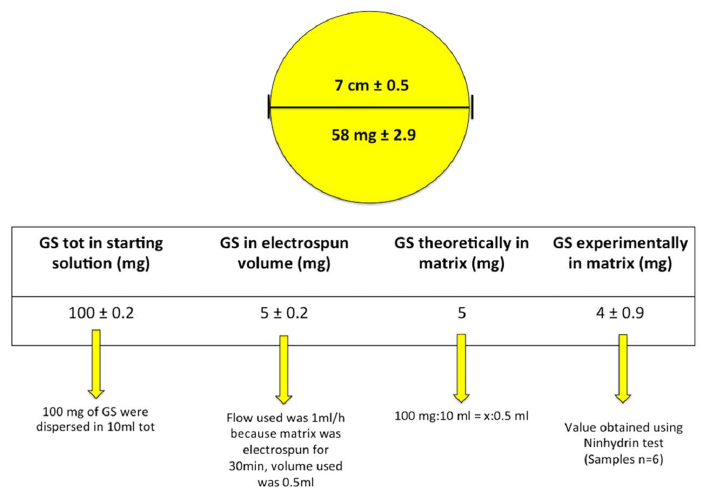
Figure 4. GS quantification in electrospun PLA-PCL matrices. The figure refers to GS amount in the whole electrospun matrix.